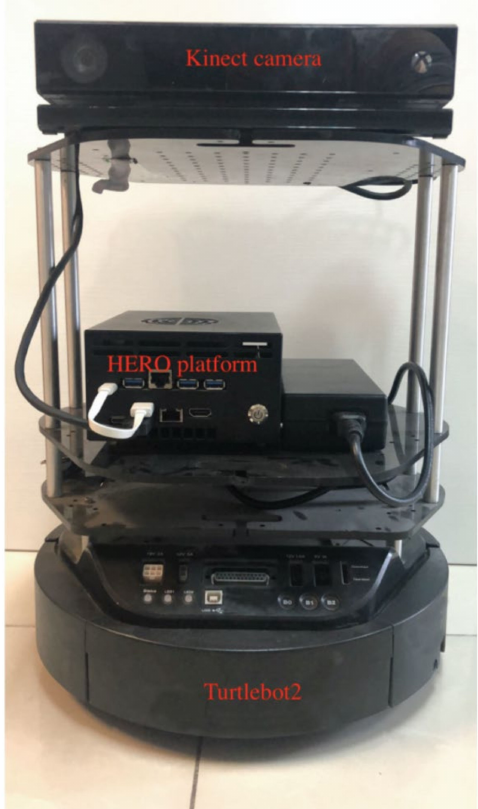
Figure 1. The processing